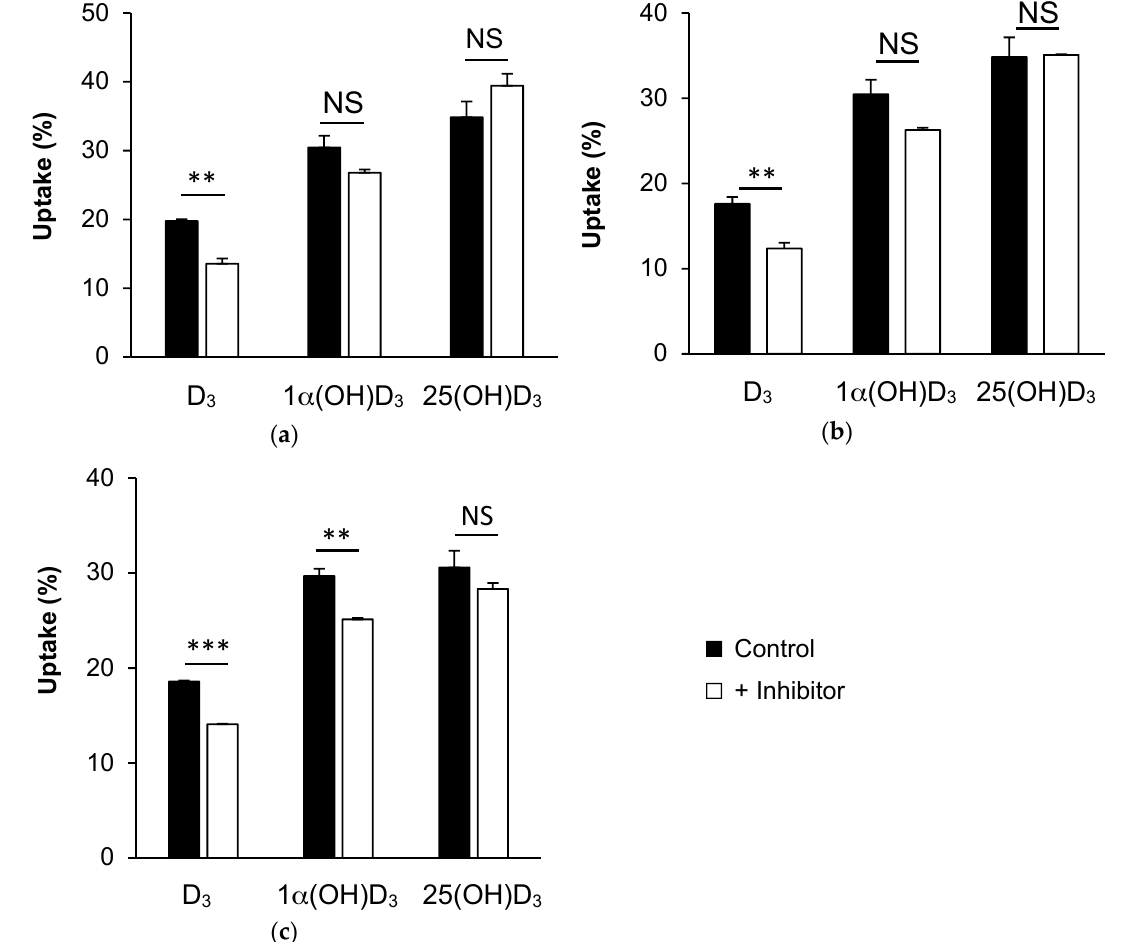
Figure 4. Uptake of vitamin D forms by Caco-2 cells in the presence of membrane protein inhibitors. Form ( a ) Uptake of D 3 , 1 α (OH)D 3 , and 25(OH)D 3 in the presence or absence of BLT1 (10 µM), an inhibitor of SR-BI ( n = 3); ( b ) Uptake of D 3 , 1 α (OH)D 3 , and 25(OH)D 3 in the presence or absence of ezetimibe glucuronide (10 µM), an inhibitor of NPC1L1 ( n = 3); ( c ) Uptake of D 3 , 1 α (OH)D 3 , and 25(OH)D 3 in the presence or absence of simvastatin (100 µM), an inhibitor of ASBT ( n = 3).** p < 0.01; *** p < 0.001, NS: not significant.